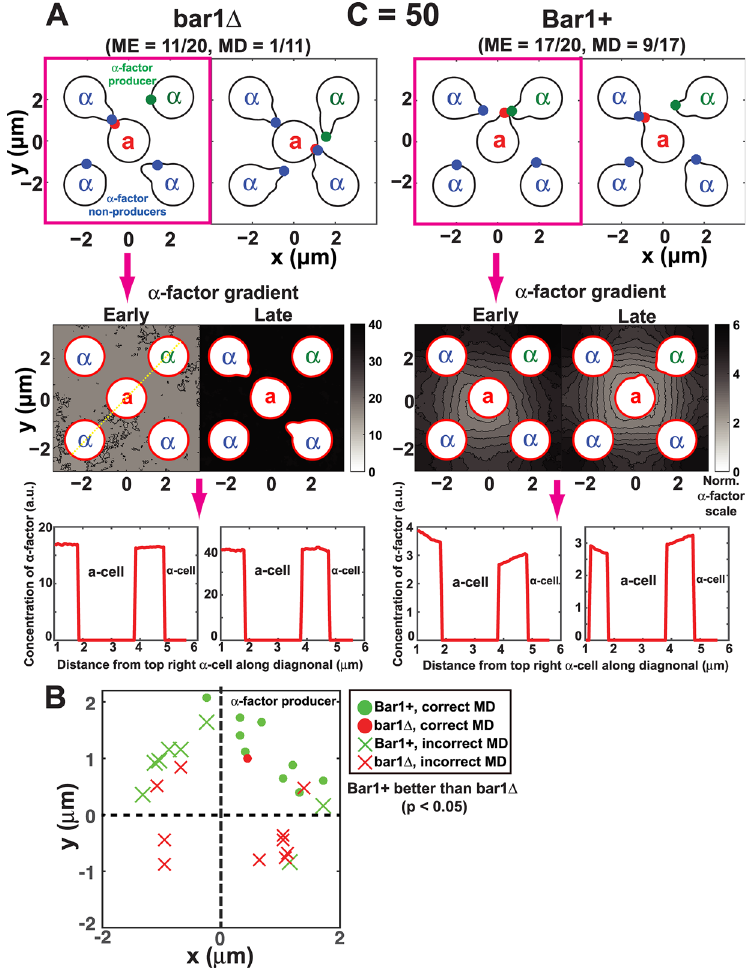
Fig 8. Role of Bar1 in mating discrimination with background α -factor. (A) Five-cell mating discrimination simulations with background α -factor in the presence and absence of Bar1. Four α -cells are arranged in a square with one a -cell in the center. One α -cell makes α -factor ( α -factor producer, top right corner) and the other three cells do not. Background α -factor source was set to C = 50. There are two sample simulations for bar1 Δ a -cells (left), and two sample simulations for Bar1+ a -cells (right). ME is mating efficiency, and MD is mating discrimination. Bar1 was secreted in a polarized fashion. The second row shows the α -factor profiles for one sample (left) simulation from each group. The third row shows the α -factor profiles along the top-right to bottom-left diagonal for one example (yellow dotted line). There is an early (T = 50s) and late (T = 570s) time point for each simulation with α -factor concentration indicated by the shading (color bar). Pheromone profiles show a steeper gradient in Bar1+ a -cell simulations; troughs represent the cell body which excludes α -factor. (B) Mating location plots for Bar1+ a -cells (green) or bar1 Δ (red) in five-cell mating discrimination simulations. Each circle (correct MD) or cross (incorrect MD) symbol represents the polarisome location of the a -cell at the time of mating. The α -cell producing α -factor was in the top-right quadrant. The Bar1+ cells showed significantly better mating discrimination (MD) than the bar1 Δ cells (p < 0.05, Fisher ’ s Exact